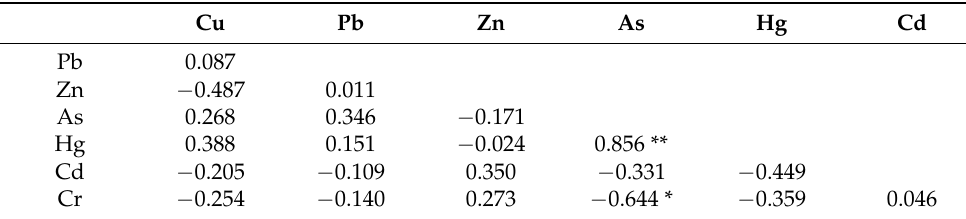
Table 6. The 2015 Pearson matrix of sediment heavy metal variables